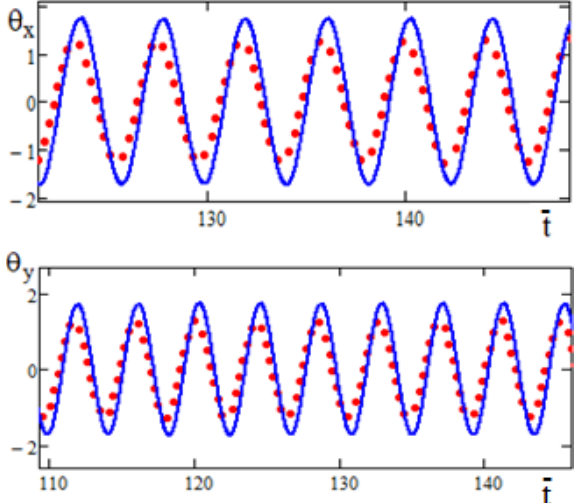
Figure 2. Oscillogram θ x = θ x ( t ) and θ y = θ y ( t ) when K 3 = 0 . 075 ,µ 1 = 0 . 09 ,µ 3 = 0. Solid lines are the results of a numerical solution, points are the results of an analytical solution.